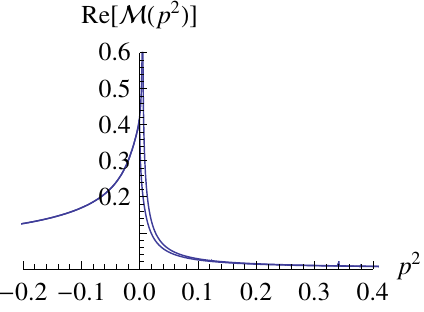
Figure 23 . Three-dimensional LW fakeon: comparison between the average continuation and the nonanalytic Wick rotation with no domain deformation at M = 1 =